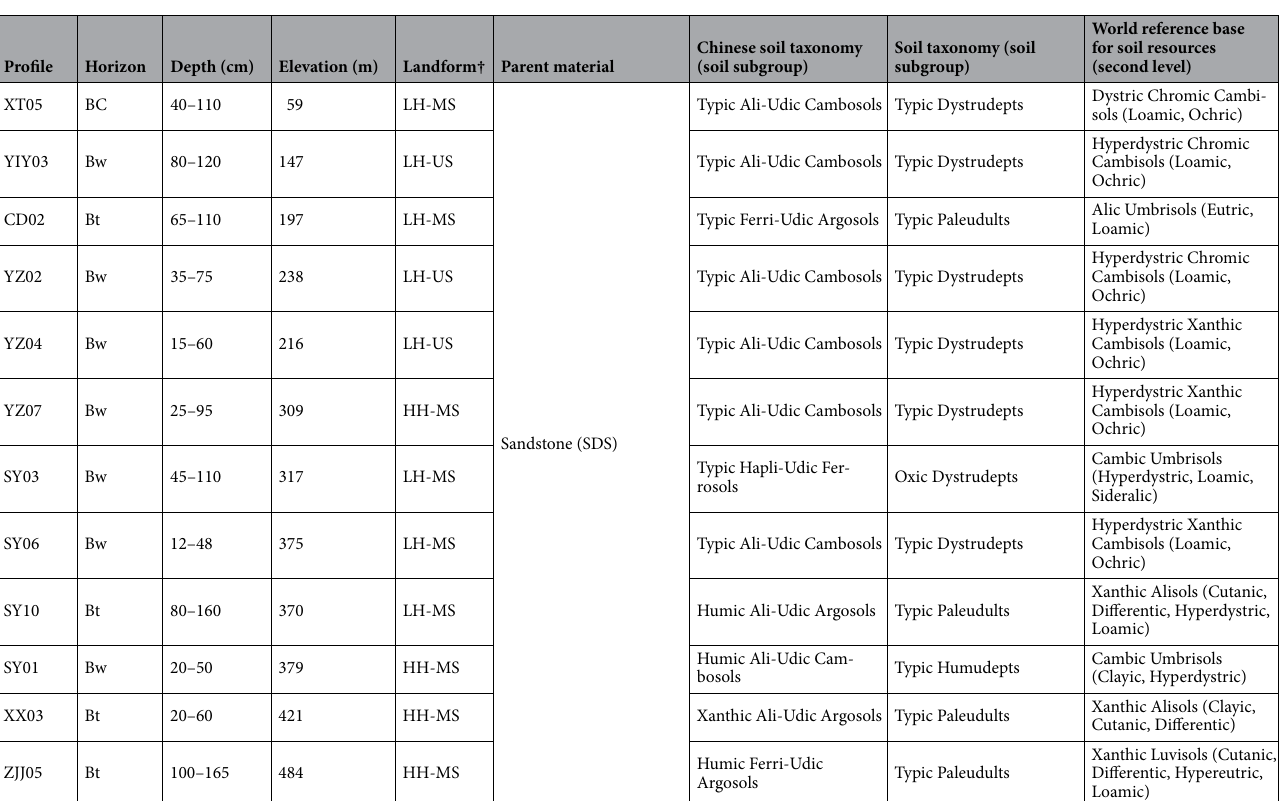
Table 1. Fundamental information about study sites and soil classification. †LH-TS: Low Hill-Top of slope; LH-US: Low Hill-Upslope; LH-MS: Low Hill-Mesoslope; LH-LS:Low Hill-Lower Slope; LH-BS: Low Hill- Bottom slopes; HH-US: High Hill-Upslope; HH-MS: High Hill-Mesoslope; HH-LS: High Hill-Lower Slope; HH-BS: High Hill-Bottom slopes; LM-MS: Low Mountain-Mesoslope; LM-LS: Low Mountain-Lower